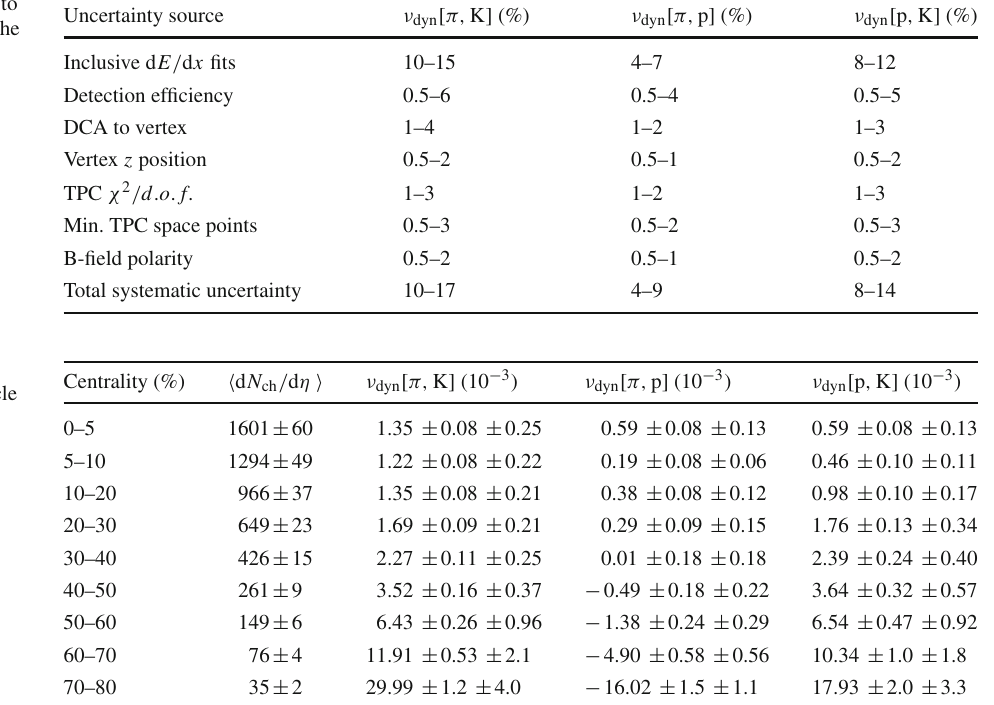
Table 1 List of contributions to the systematic uncertainty of the particle ratio fluctuations